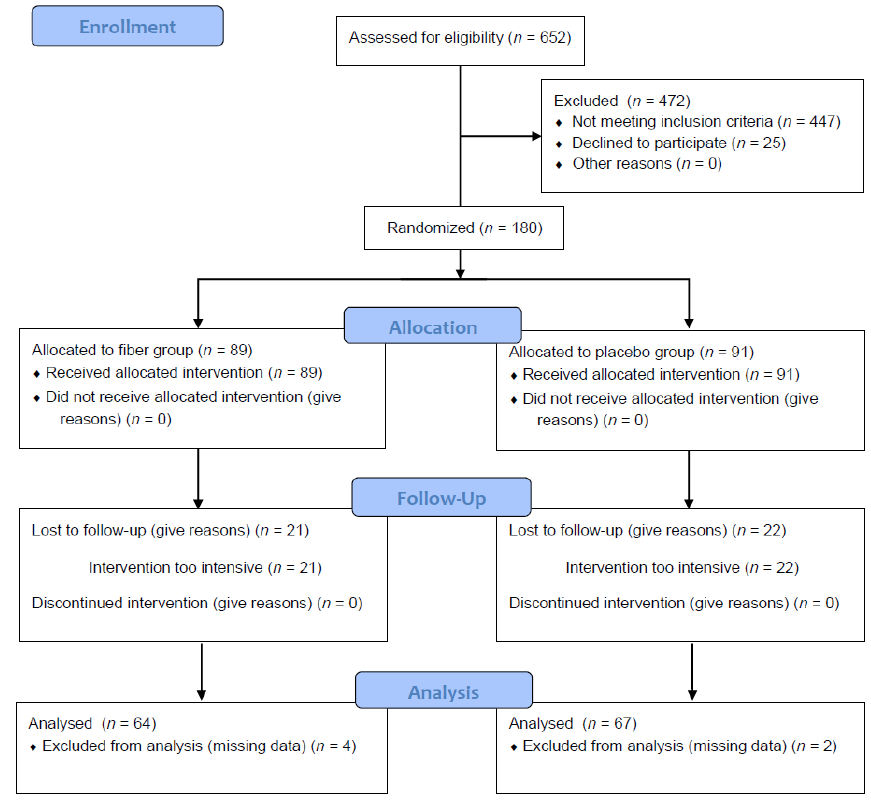
Figure 1. CONSORT flow diagram.